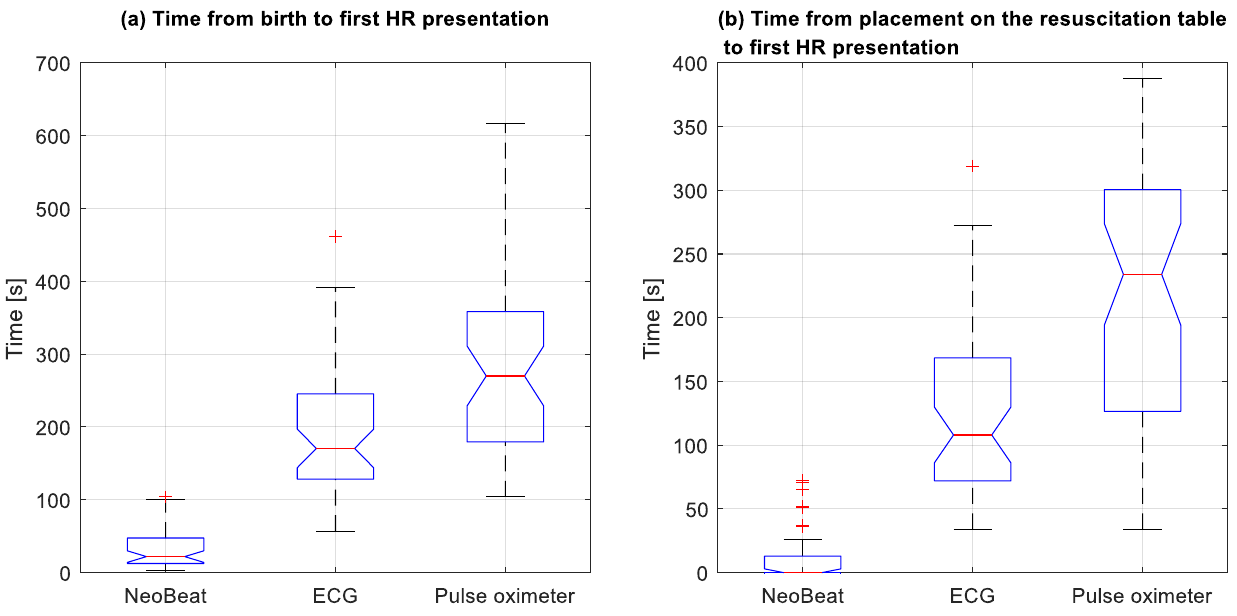
Figure 3. Box plots with comparison of time to first heart rate presentation from ( a ) the time of birth and ( b ) placement on the resuscitation table. HR, heart rate. Note: One pulse oximeter outlier at 1005 s in ( a ) and 963 s in ( b ) is not shown.